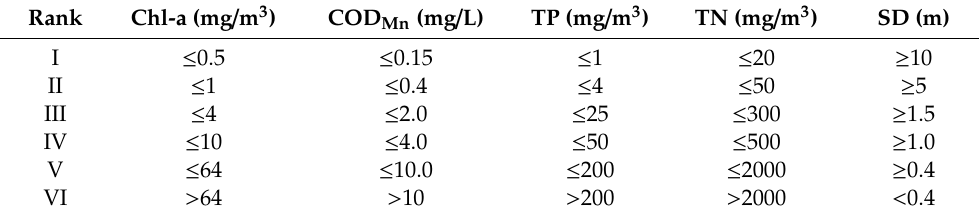
Table 2. Criteria of grading index for eutrophication of